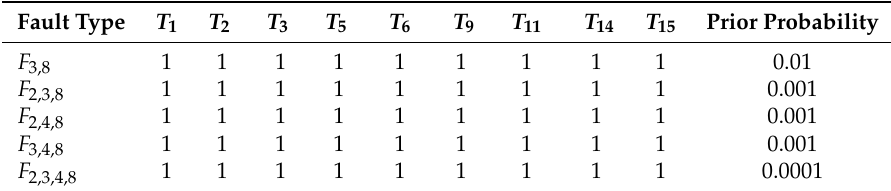
Table 13. Fault fuzzy groups of the system in Experiment